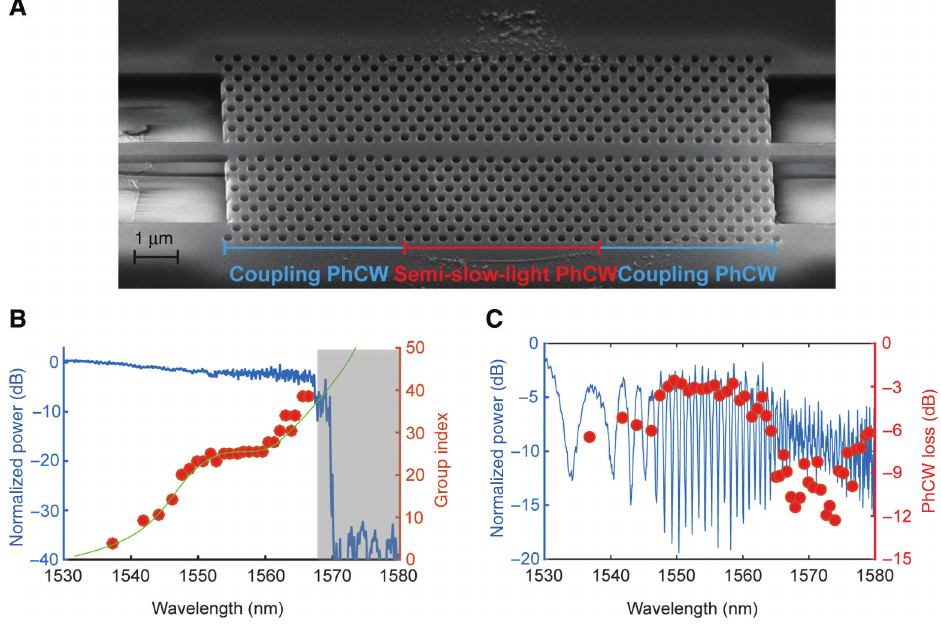
Figure 3: Characterization of the fabricated PhCW. (A) SEM of PhCW with hole diameter of 214 nm (designed 194 nm). (B) Transmission spectrum of the PhCW (blue curve) and its group index (red dots) in each wavelength. (C) Loss (red dots) in different wavelength and spectra of the PhCW MZI (blue curve).